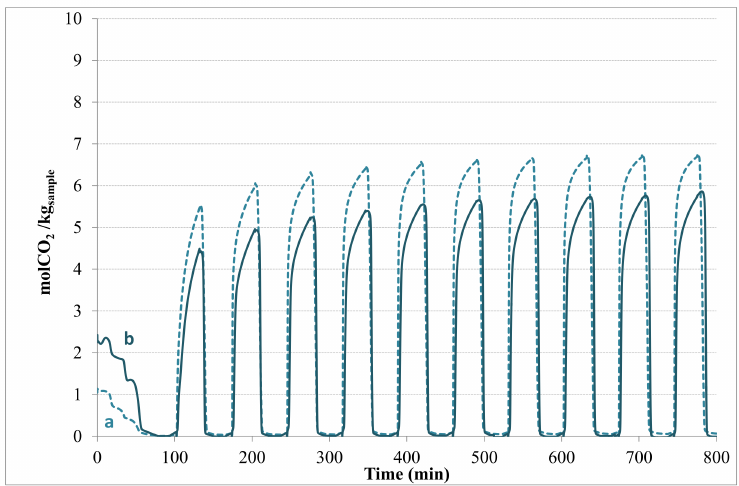
Figure 7. Cyclic CO 2 sorption/desorption TGA test: left: (a) C56, and (b)